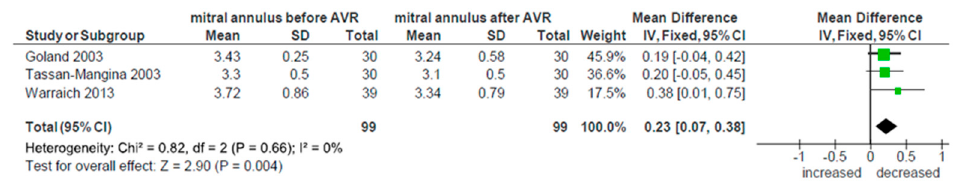
Figure 6. The change in LVEDD after AVR.